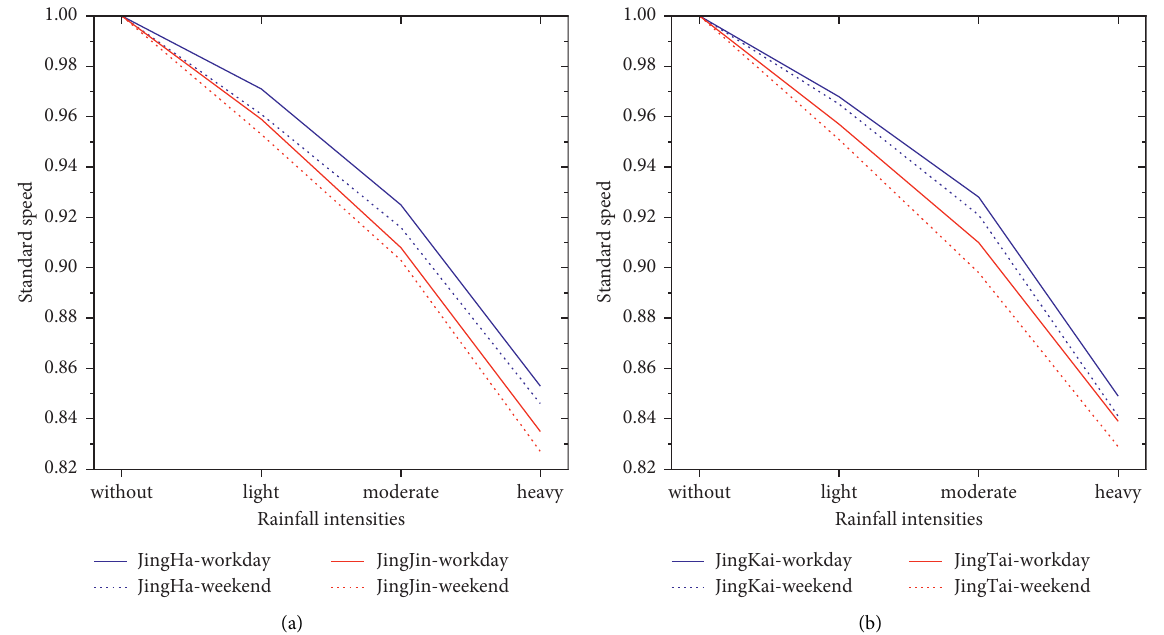
Figure 2: Standard speed distribution of highway under different rainfall intensities: (a) highway in Tongzhou District; (b) highway in Daxing District.